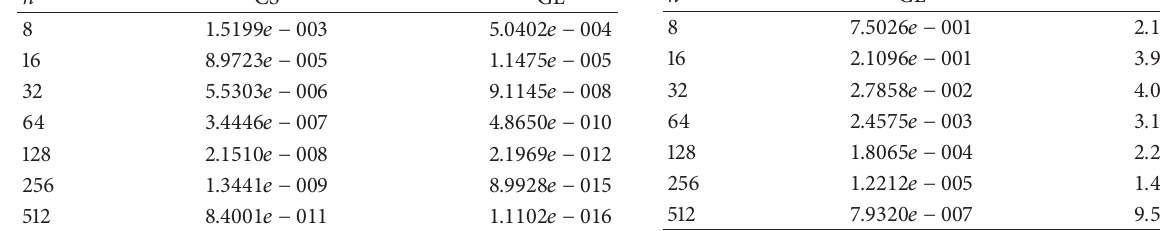
Table 6: Errors of integration ∫